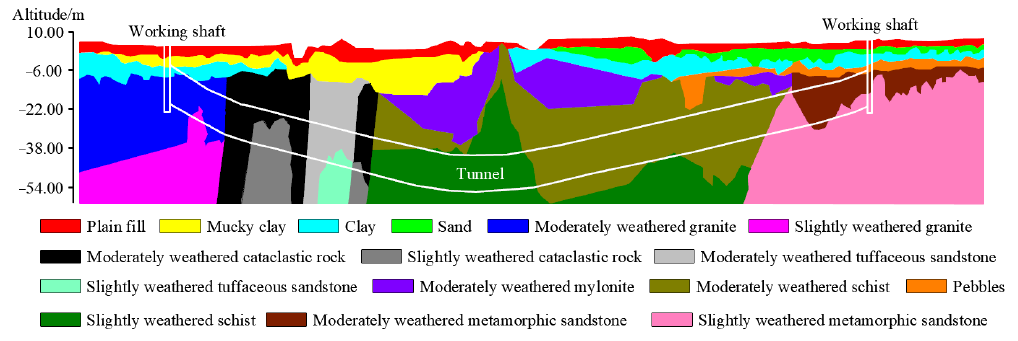
Figure 4. Engineering geological profile.